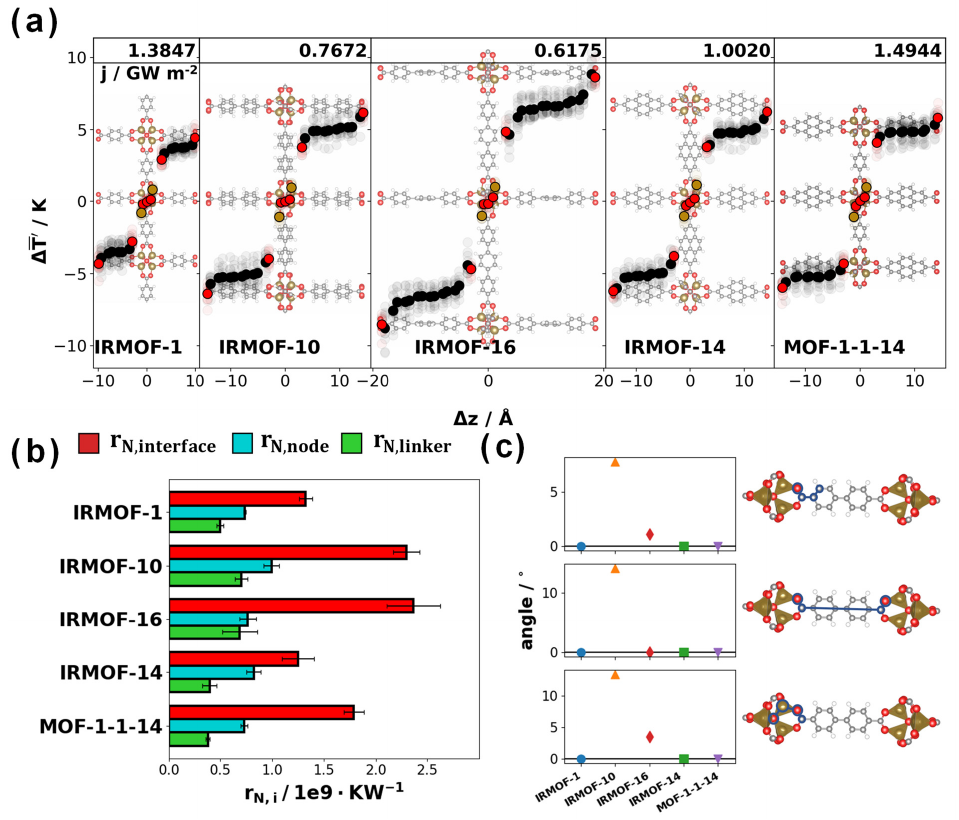
Figure 5. ( a ) Local effective temperature profiles of a node and its adjacent linkers obtained from the kinetic energies of the atoms during NEMD simulations for the investigated MOFs. The temperature profiles were averaged across all MOF building blocks at a distance of at least 50 Å from the thermostat center and over a simulation time of 10 ns. The semi-transparent data points in the background represent the local effective temperatures before spatial averaging. The simulation cells used to extract these data were chosen to be similar in length, resulting in the following supercells specified relative to the conventional unit cells: 13 × 2 × 2 for IRMOF-1, 10 × 2 × 2 for IRMOF-10, IRMOF-14 and MOF-1-1-14, and 8 × 2 × 2 for IRMOF-16. The numbers above the tem- perature profiles designate the heat fluxes through the respective cells. ( b ) Thermal transport- channel insulance contributions for linkers, nodes, and interfaces in the investigated MOFs. The values were obtained from linear fits across the individual building units for differently long sim- ulation cells to correct for finite-size effects using the same method as that used for the thermal conductivity. The error bars result from the standard errors of the finite-size extrapolation. ( c ) Di- hedral angles between the carboxylate and the terminal phenylene (top), between the carboxylate groups attached to two adjacent nodes (middle), and between a plane through the central part of the node and the carboxylate groups of the linker (bottom) for the relaxed structures of all investi- gated MOFs. The definitions of the dihedral angles are illustrated in the right panels of the plot (colors representing the different atom types: Zn—brown, O—red and blue, C—grey, H—white).